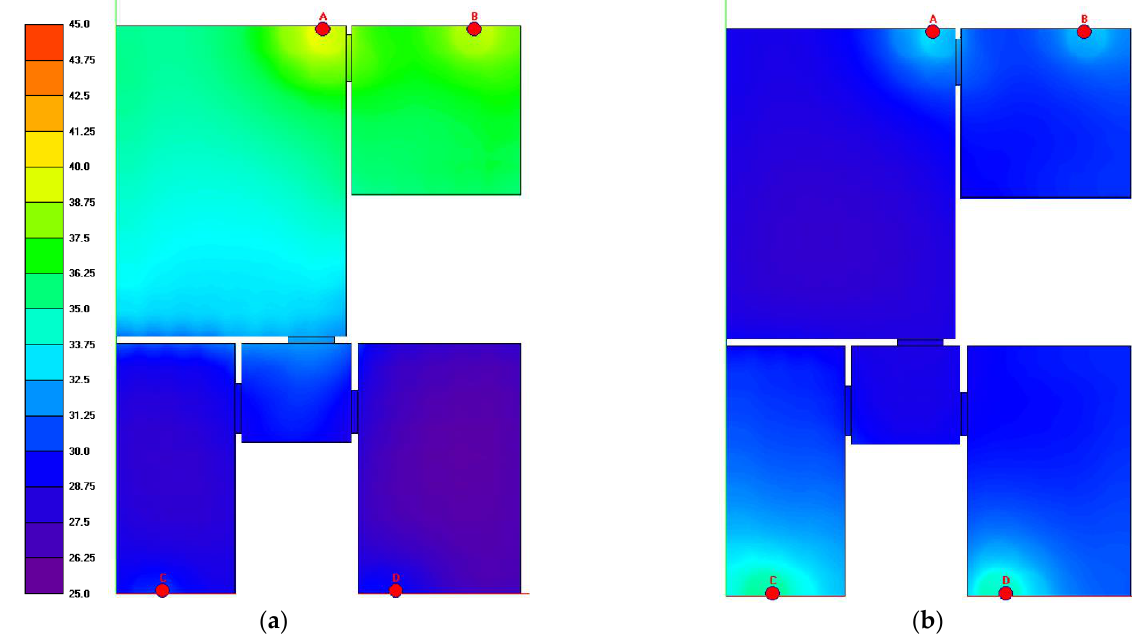
Figure 17. Three-room apartment. ( a ) “Night” configuration A-weighted sound pressure levels. ( b ) “Day” configuration A-weighted sound pressure levels.